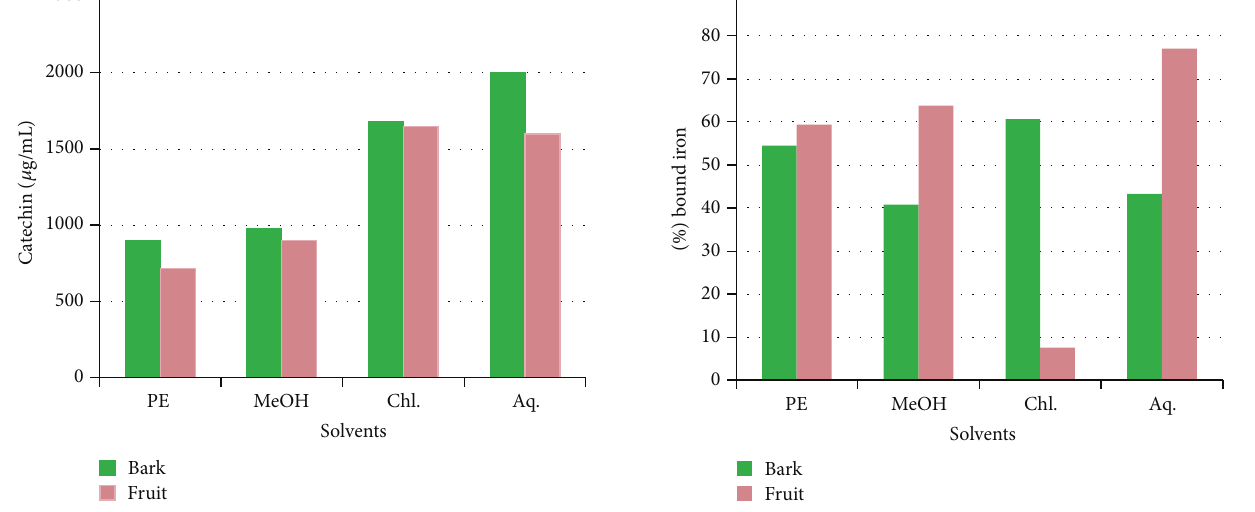
Figure 16: Total flavonoids content (TFC) of different parts of C. ambrosioides .